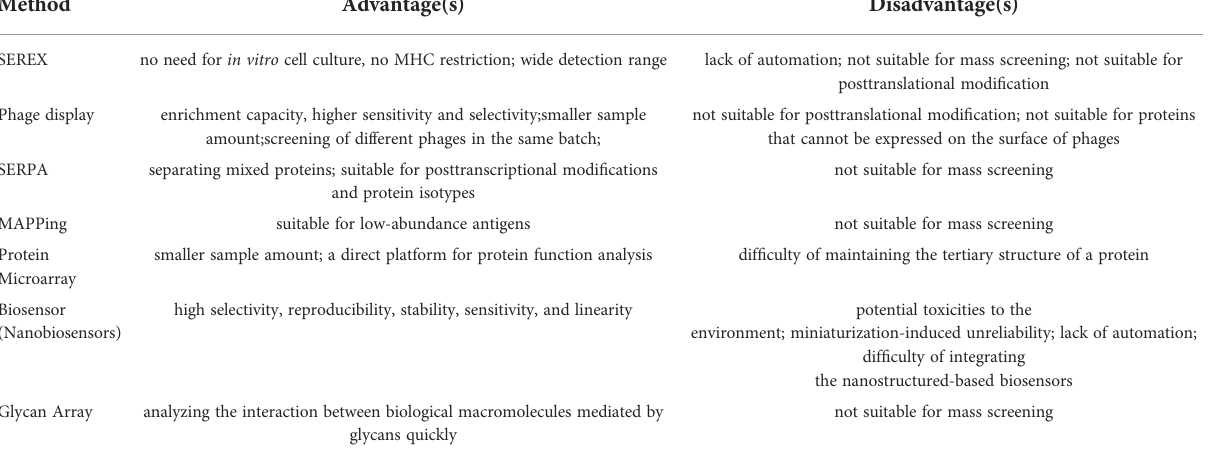
TABLE 3 Advantages and disadvantages of methods for detecting